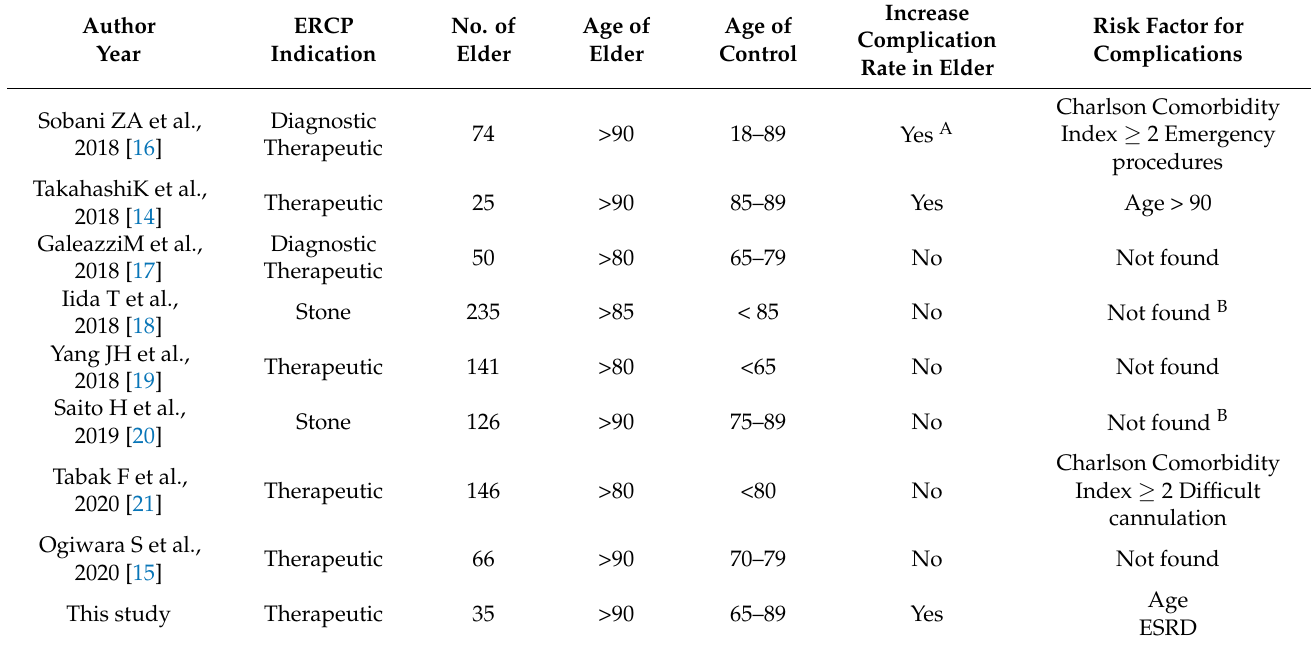
Table 5. Publications regarding safety issue of elder people receiving ERCP in recent 5